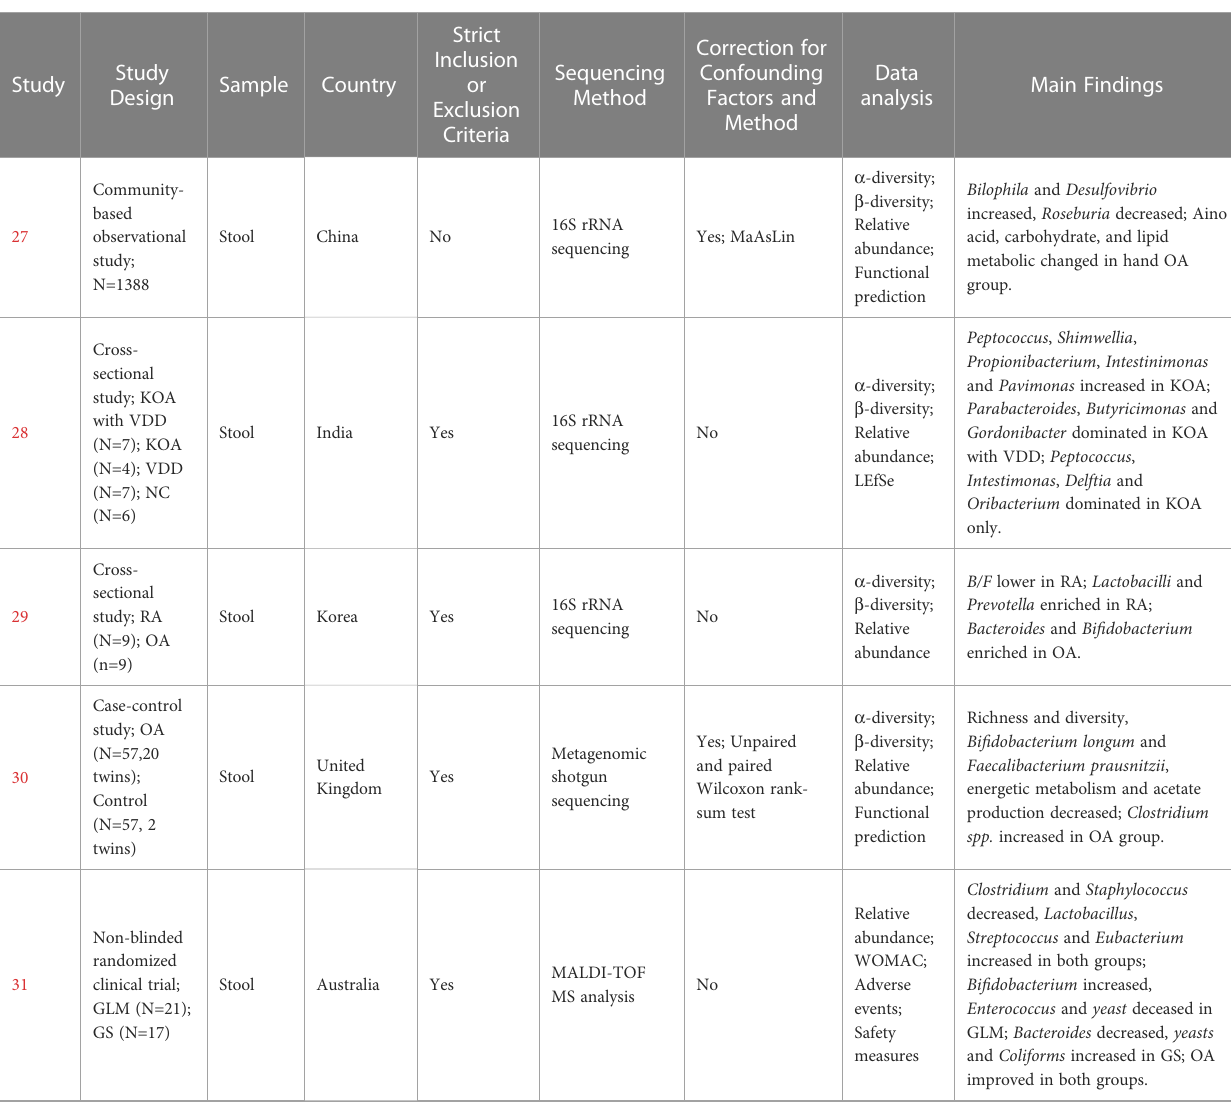
TABLE 1 Human Studies on GMB and